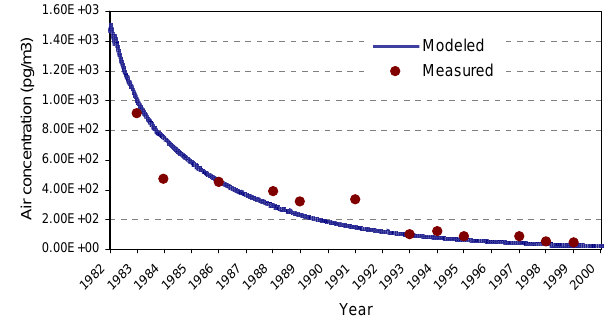
Fig. 9. Modeled and measured atmospheric concentration of α - HCH averaged over the